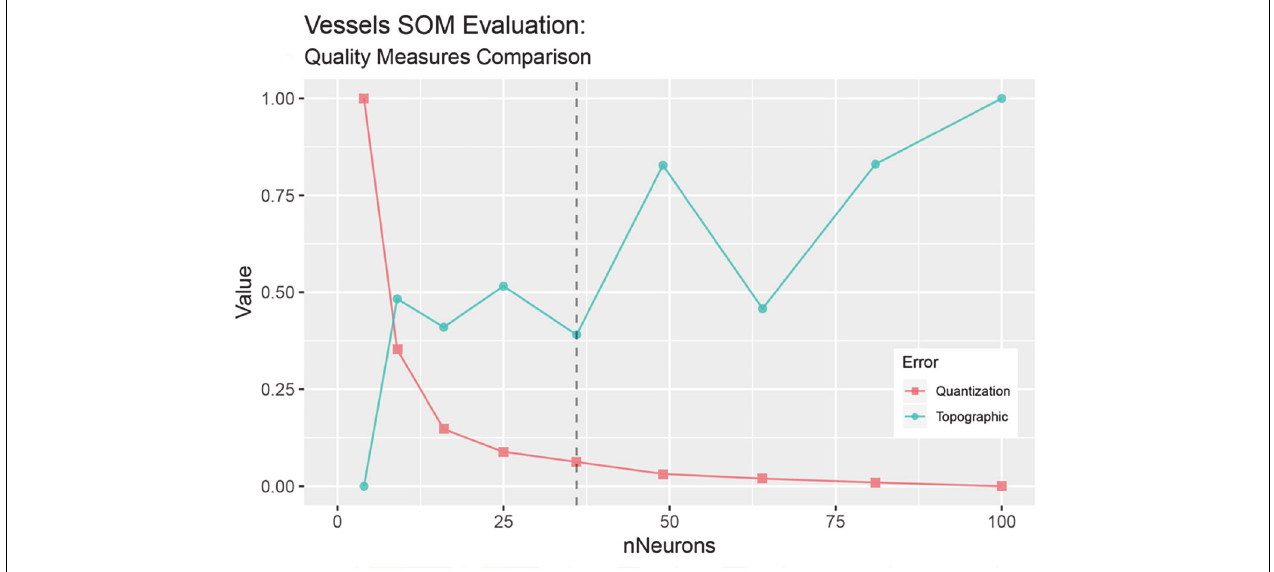
FIGURE 2 | SOM quality evaluation through the optimization of quantization and topographic